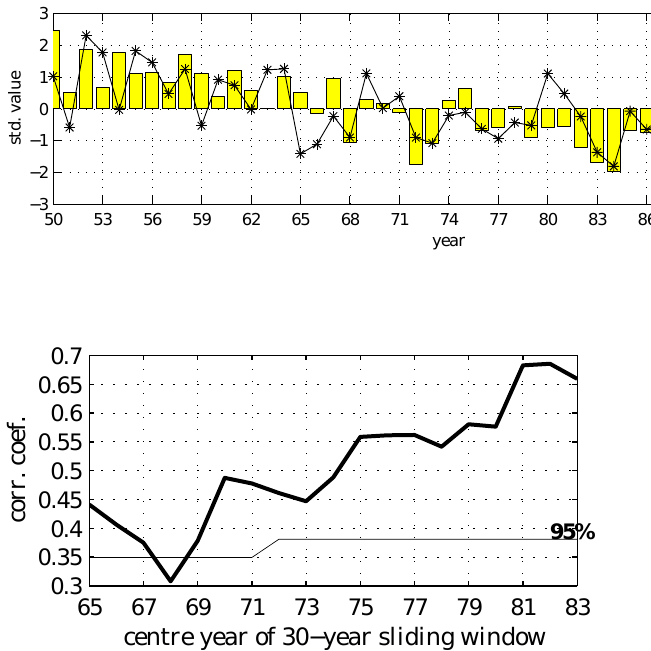
Fig. 3. Linear correlation coefficients between the July–September Sahelian rainfall (JAS 0) and the previous September-November Guinean rainy season (SON − 1) computed on detrended series with successive 30-year sliding windows (1950–1998). Thin line: signif- icance level at 95%. Data source: Hulme